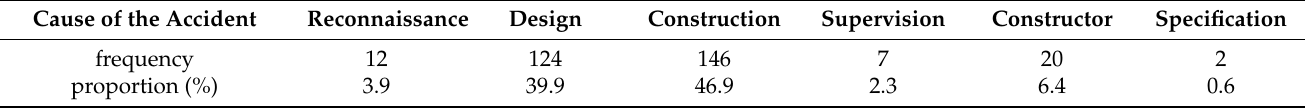
Table 1. Investigation form of causes of foundation pit accidents [1].